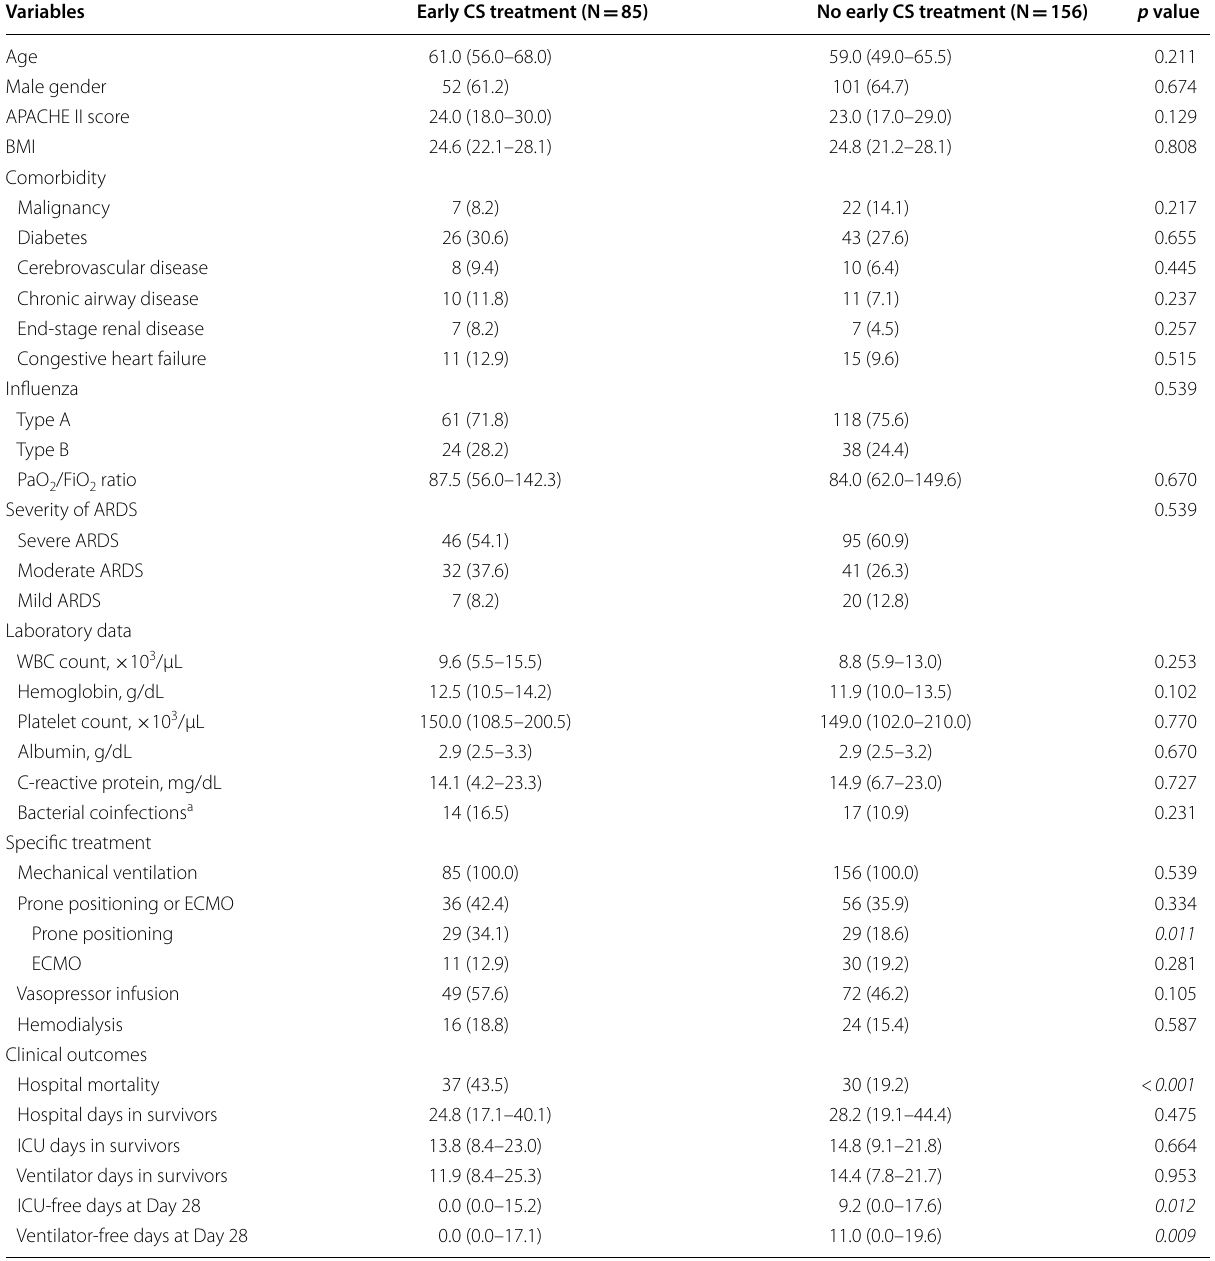
Table 1 Characteristics and outcomes between influenza-associated ARDS patients with versus without early corticosteroid